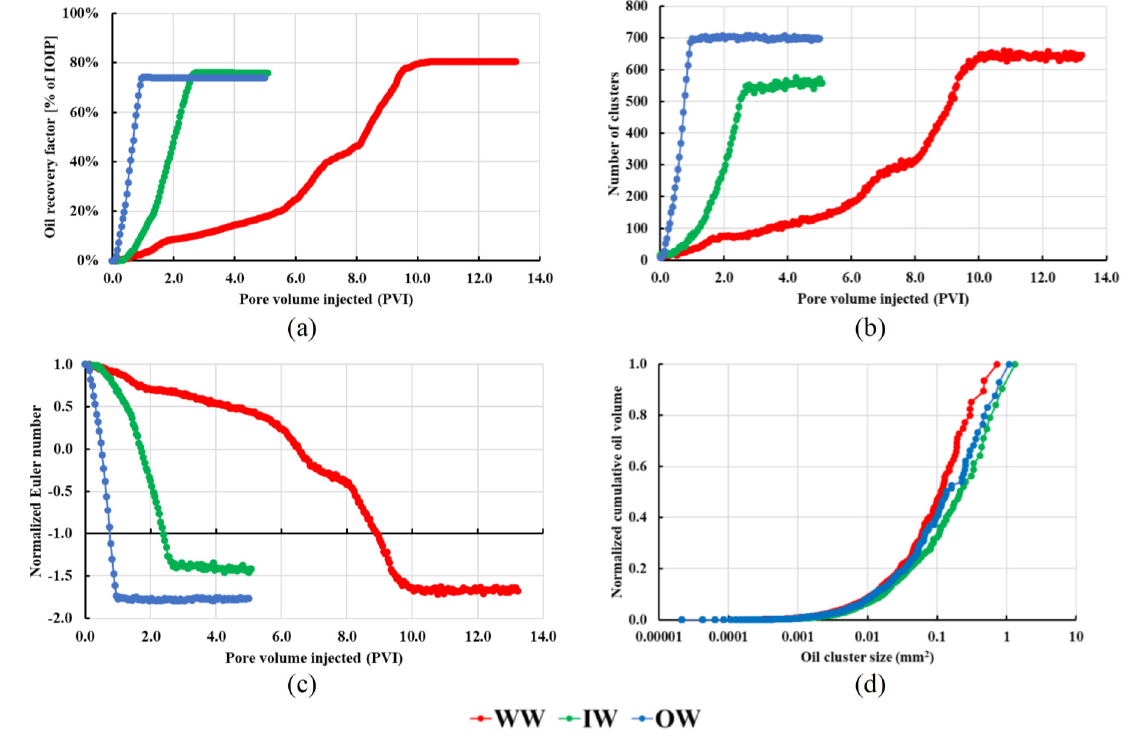
Figure 4. Results for SSW flooding at different wettability states with 0.1 µL/min. Dynamic change in ( a ) oil recovery ( b ) cluster number, ( c ) oil connectivity as a function of pore volumes injected, and ( d ) the residual oil cluster size distribution.